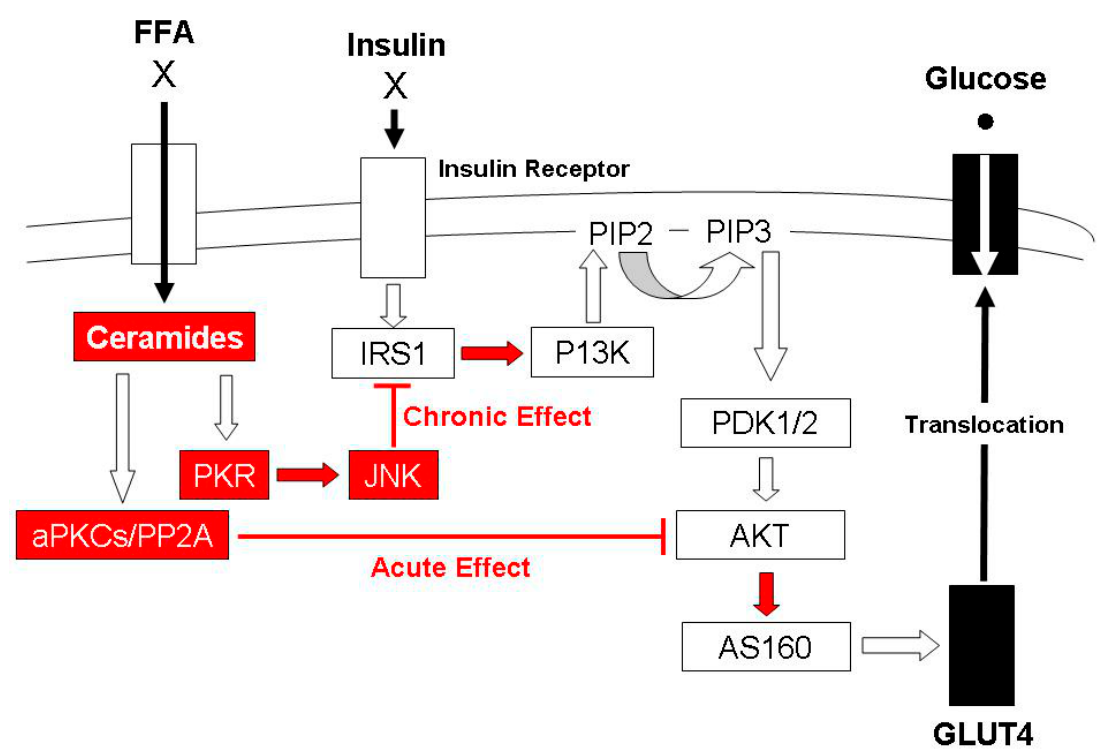
Figure 1. Schematic representation of the deleterious influence of elevated intramuscular ceramide concentration on two different steps of the insulin signal transduction pathway. The acute effect involves ceramide-induced inhibition of protein kinase B (Akt) via protein phosphatase 2 (PP2A) or atypical protein kinase Cs (aPKCs) while a chronic effect occurs due to activation of the protein kinase R (PKR) stress pathway which negatively impacts insulin receptor substrate 1 (IRS1) [8].